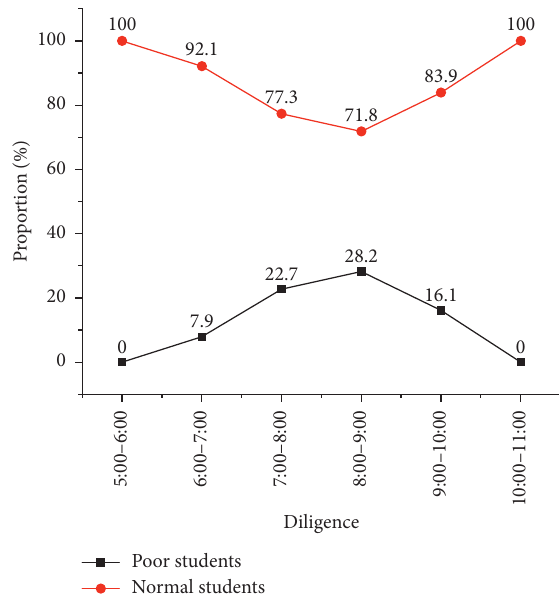
Figure 9: Proportion of poor students in different times of first meal.